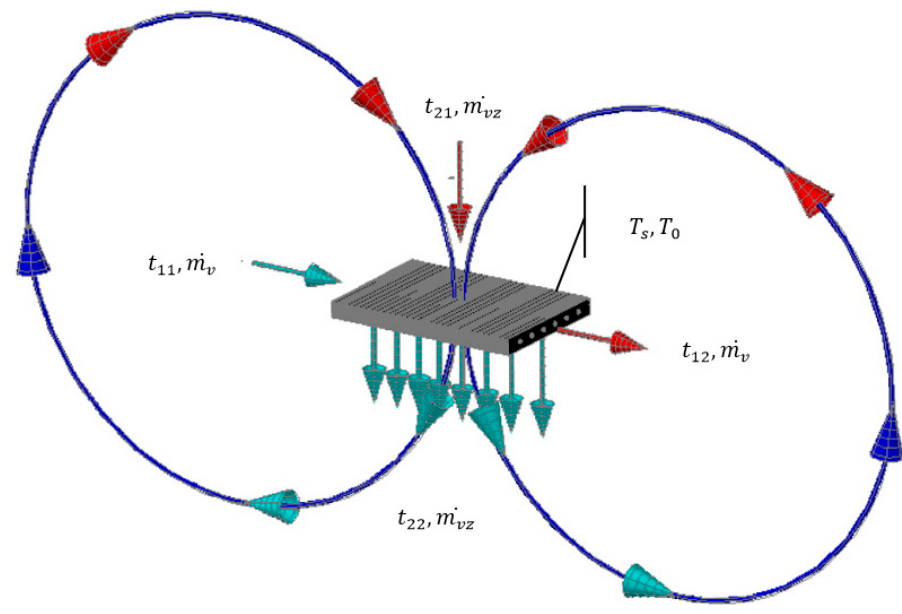
Figure 19. Model of passive cooling beam.